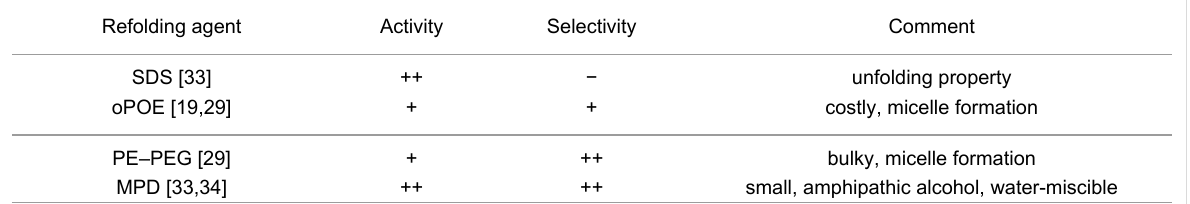
Table 1: Comparison of common solubilizing agents for membrane proteins.